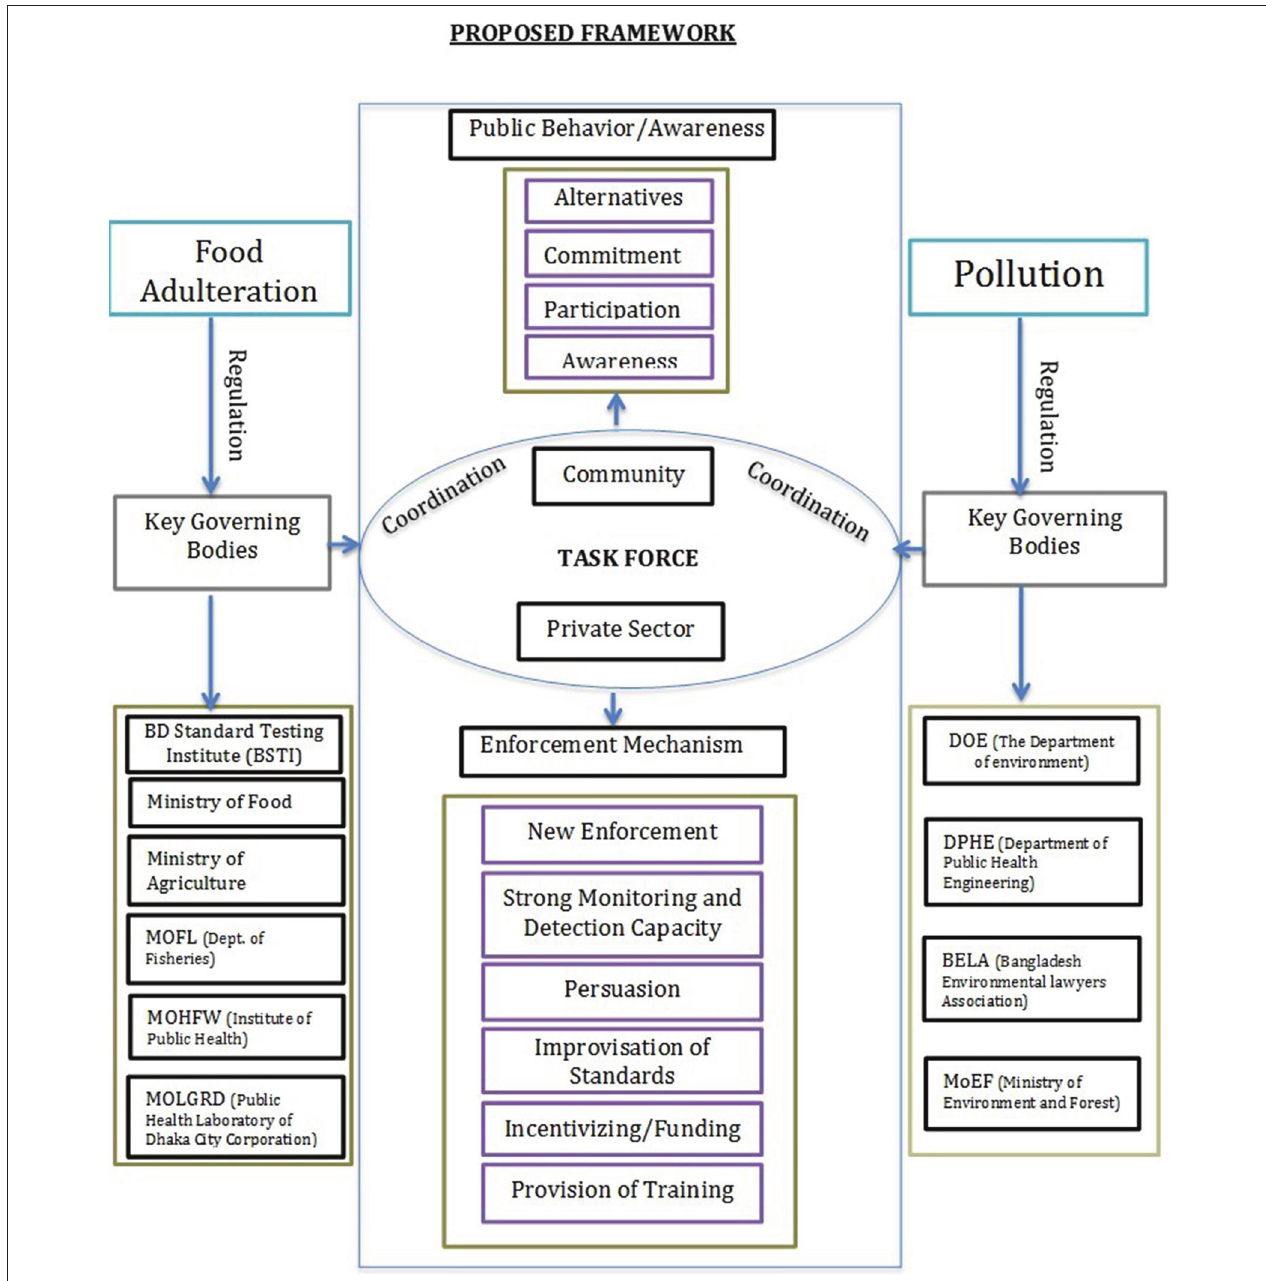
FIGURE 8 | Proposed regulatory framework addressing food adulteration and aquatic pollution